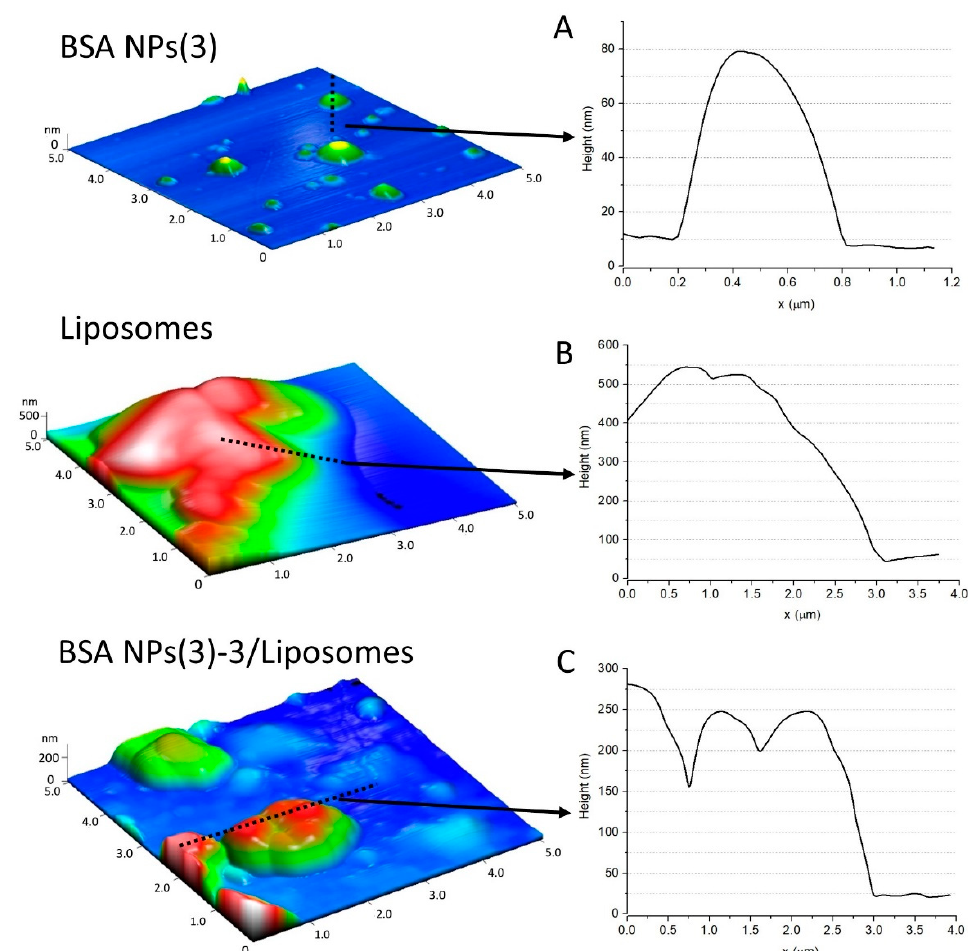
Figure 7. Three-dimensional AFM images ( left ) and the profiles ( right ) of BSA NPs(3) ( A ), liposomes ( B ) and BSA NPs(3)-3 ( C ). Samples were deposited on the mica substrate.